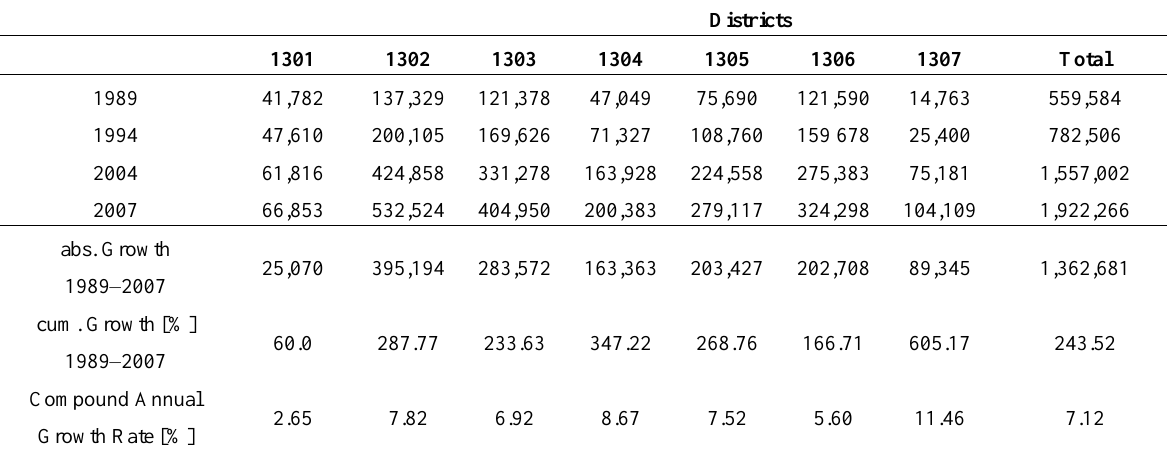
Table 5. Population growth and urban expansion rates for the districts of interest between 1989 and 2007.